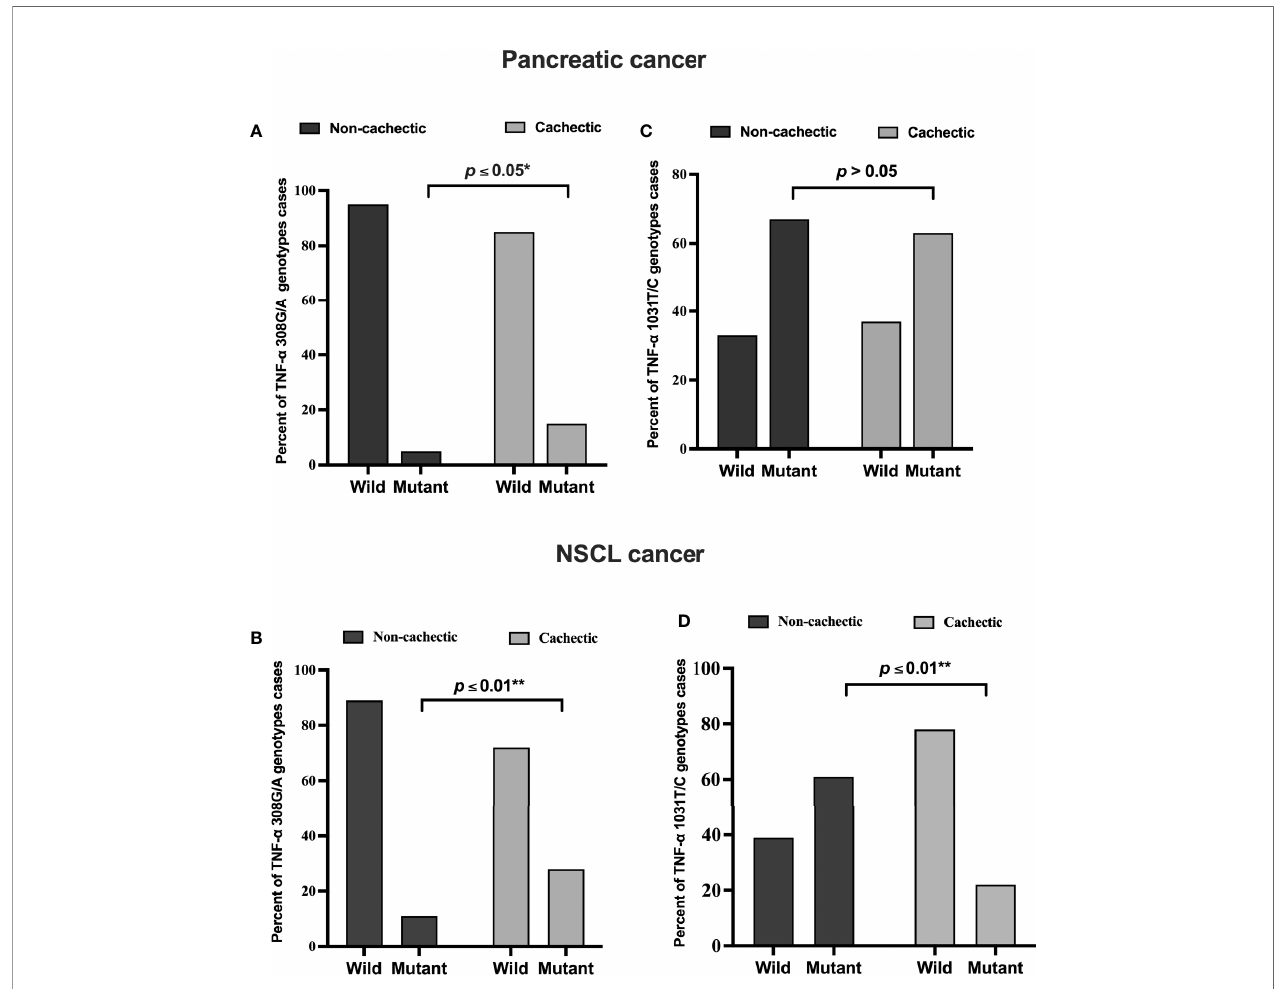
FIGURE 1 | Frequencies of TNF- a 308 G/A (rs1800629) wild and mutant alleles among (A) pancreatic (B) NSCL cancer patients and TNF- a T/C 1031 (rs1799964) wild and mutant alleles among (C) pancreatic and (D) NSCL cancer patients. Comparison between wild and mutant alleles as performed by chi-square test at *p < 0.05. **Signi fi cant difference at p ≤ 0.01. NSCL, non-small cell